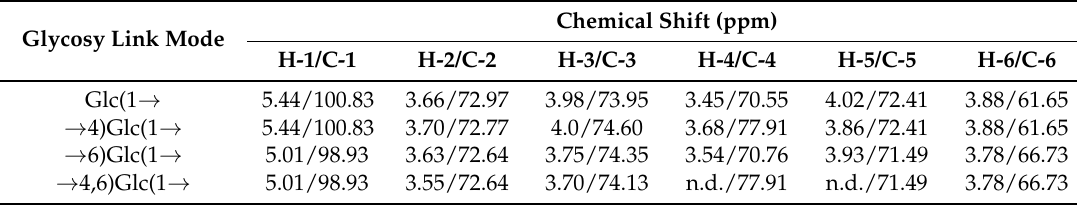
Figure 4. The possible structure unit of polysaccharide H-1-2.